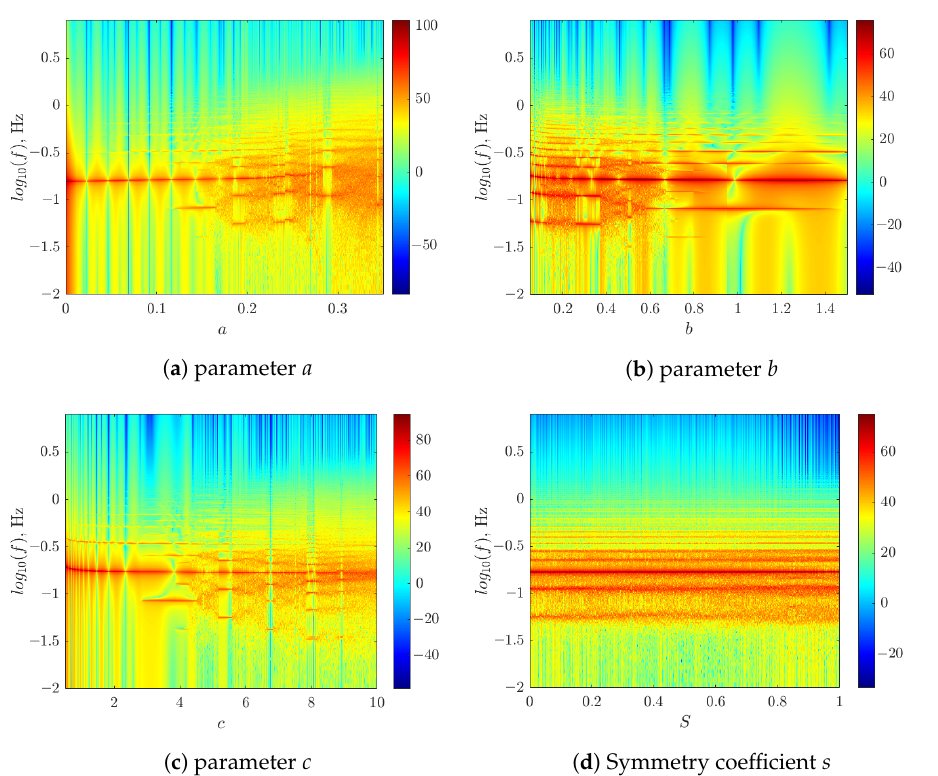
Figure 9. Spectrum diagrams for Rössler system simulated with h = 0.01